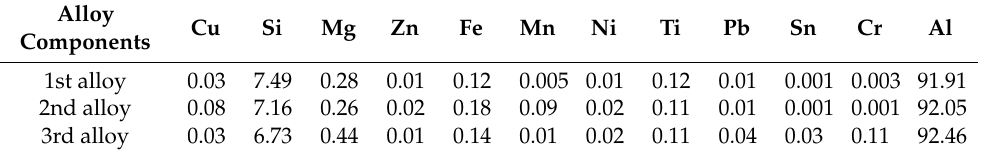
Table 6. Composition of alloy prepared under different process conditions.